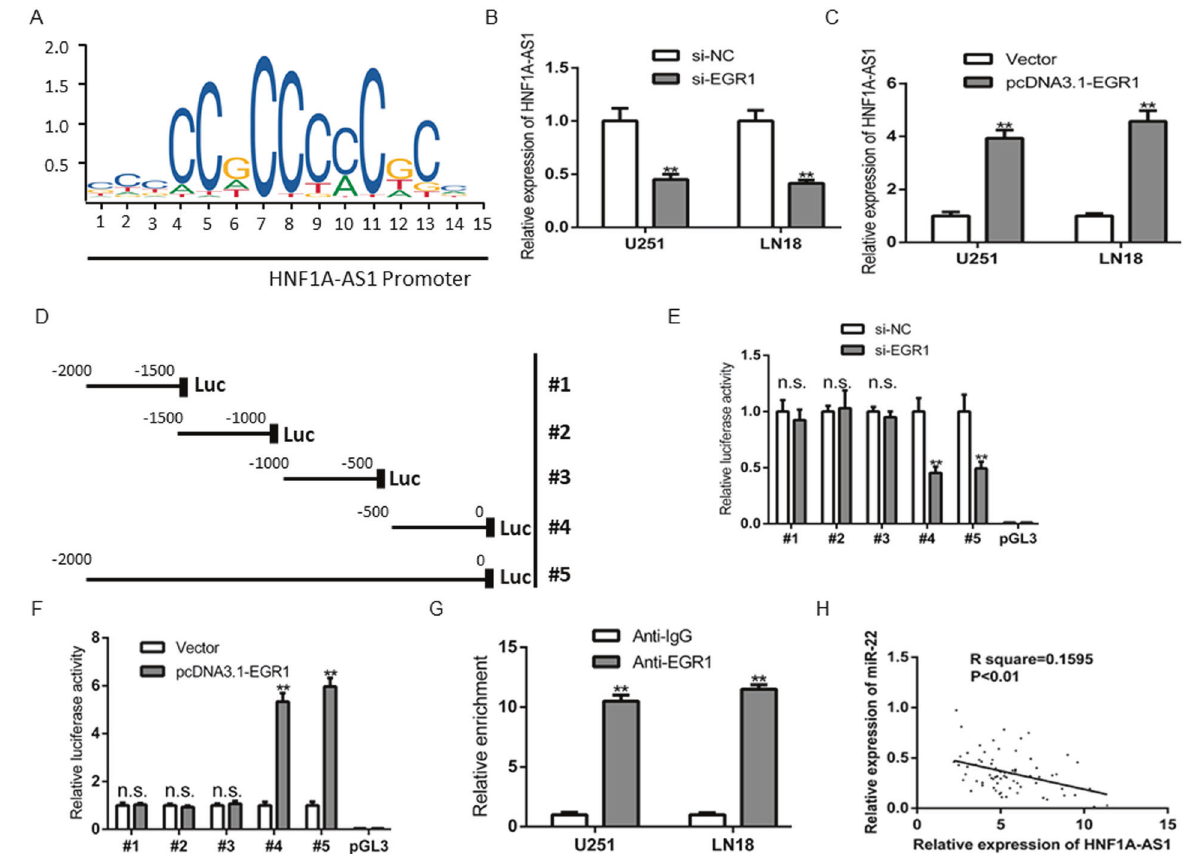
Fig. 3 The transcription factor EGR1, specially activate HNF1A-AS1 expression at transcriptional level. A JASPAR database was adopted to predict the putative bind site of EGR1 on the promoter region of HNF1A-AS1. B , C The expression level of HNF1A-AS1 was tested in GBM cells transfected with si-EGR1 or pcDNA3.1-EGR1 using RT-QPCR assay. ** P < 0.01 vs. si-NC or ** P < 0.01 vs. Vector. D Serial truncations of HNF1A- AS1 promoter fragments spanning from − 2000/ − 1500/ − 1000/ − 500/ to 0. E , F This promoter fragments were cloned into pGL3-basic vectors, and dual luciferase reporter assays were performed to assess the exact EGR1 binding site on the HNF1A-AS1 promoter region. ** P < 0.01 vs. si-NC or ** P < 0.01 vs. Vector, n.s. indicates no signi fi cance relative to si-NC or Vector. G ChIP assay showed that the binding af fi nity between EGR1 and HNF1A-AS1 promoter region. ** P < 0.01 vs. IgG. H Pearson ’ s correlation was performed to analyze the relationship between HNF1A-AS1 expression and miR-22 expression in 72 GBM